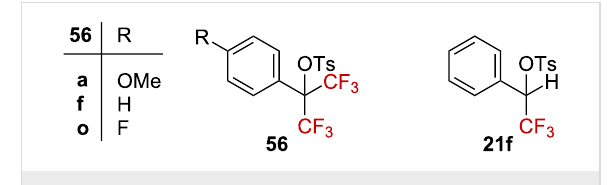
Figure 8: Structure of tosylates 56 and 21f .